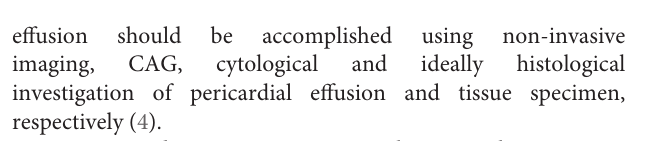
FIGURE 3 | Invasive diagnostic workup including surgery and histopathology, confirming the diagnosis angiosarcoma of the